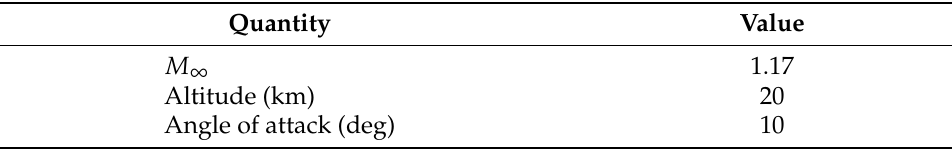
Table 15. Flow Conditions.